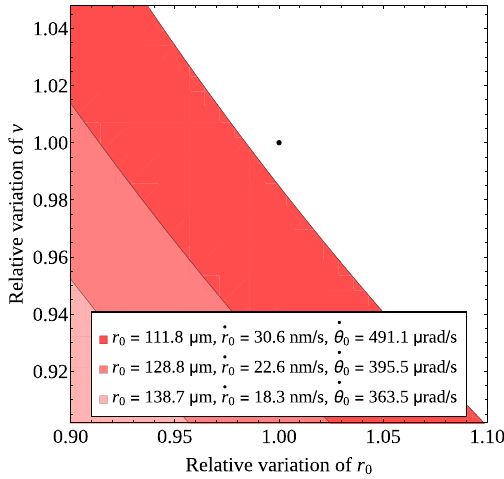
Fig. 17 Impact of relative error on the choice of the initial conditions on the qualitative behaviour of the trajectory. The black dot represents threepossiblechoicesofinitialconditions(asreportedinthelegend)for which S is expected to perform a closed non-collisional orbit around P in the Newtonian case. The three coloured regions represent the region of the parameter space of initial conditions for which we expect colli- sion between S and P in the Newtonian case in the three cases (where the color code correspond to the different choices of initial conditions, as reported in the legend). In each case, we can see that in order to qualitatively preserve the expected closed orbit, we should keep errors on the initial conditions fixing below some value that ranges between 1% for r 0 = 111 . 8 μ m to ∼ 10% for r 0 = 138 . 7 μ